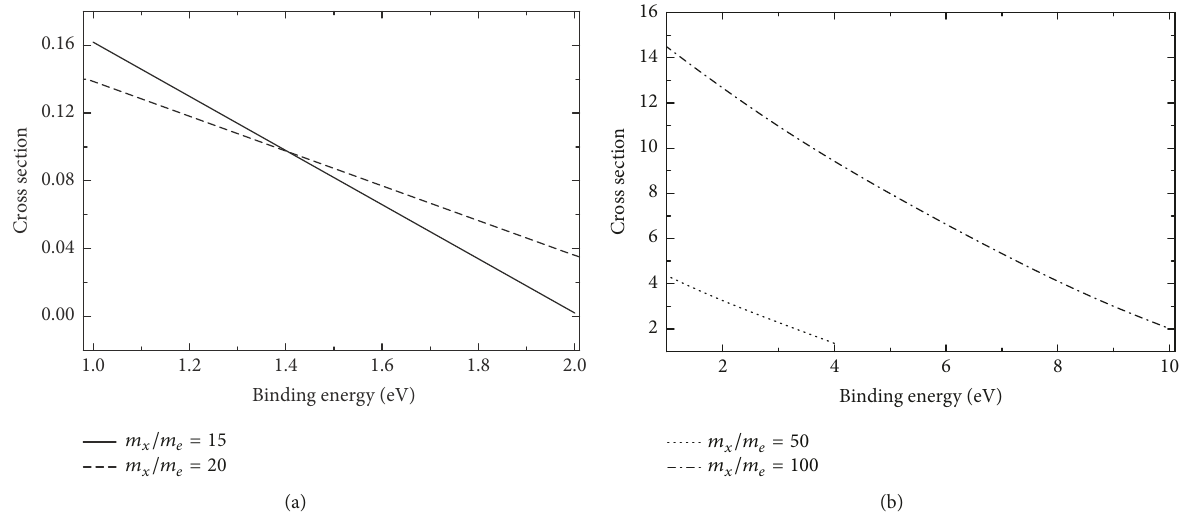
Figure 10: The cross section 𝜎 av in units of 𝜎 0 as a function of 𝑏 in eV for 𝑥 = 𝑚 𝜒 /𝑚 𝑒 = 15 (solid line) and 20 (dashed line) (a) and for 𝑥 = 𝑚 /𝑚 = 50 and 100 (b) (the lower curve corresponds to the smaller 𝑥 𝜒 𝑒